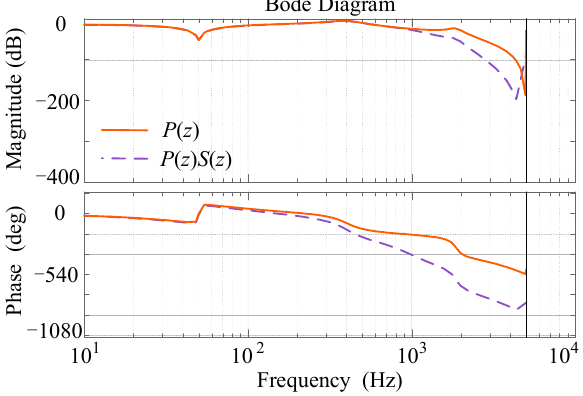
Figure 7. Phase frequency characteristics of P(z) and P(z)S(z).